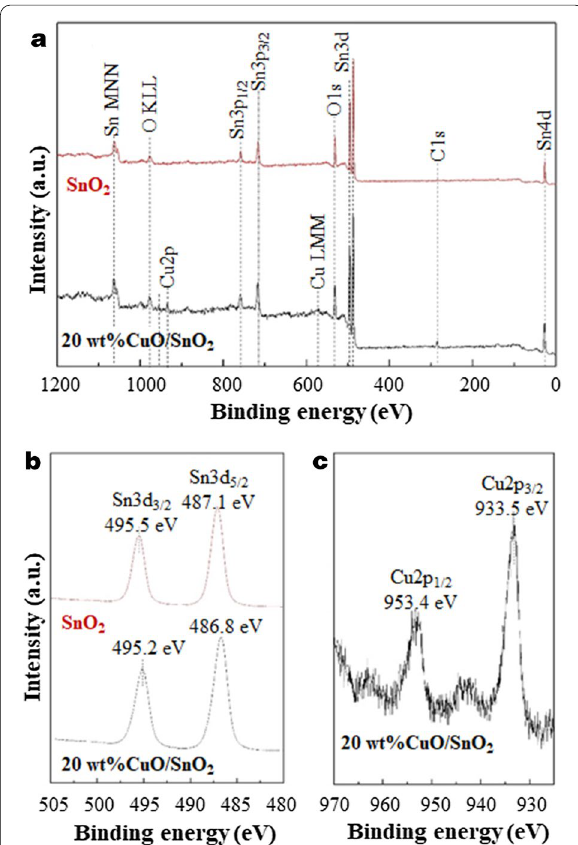
Fig. 7 a Survey and high-resolution XPS spectra of the b Sn3d and c Cu 2 p core levels of SnO 2 and 20 wt% CuO/SnO 2 NPs